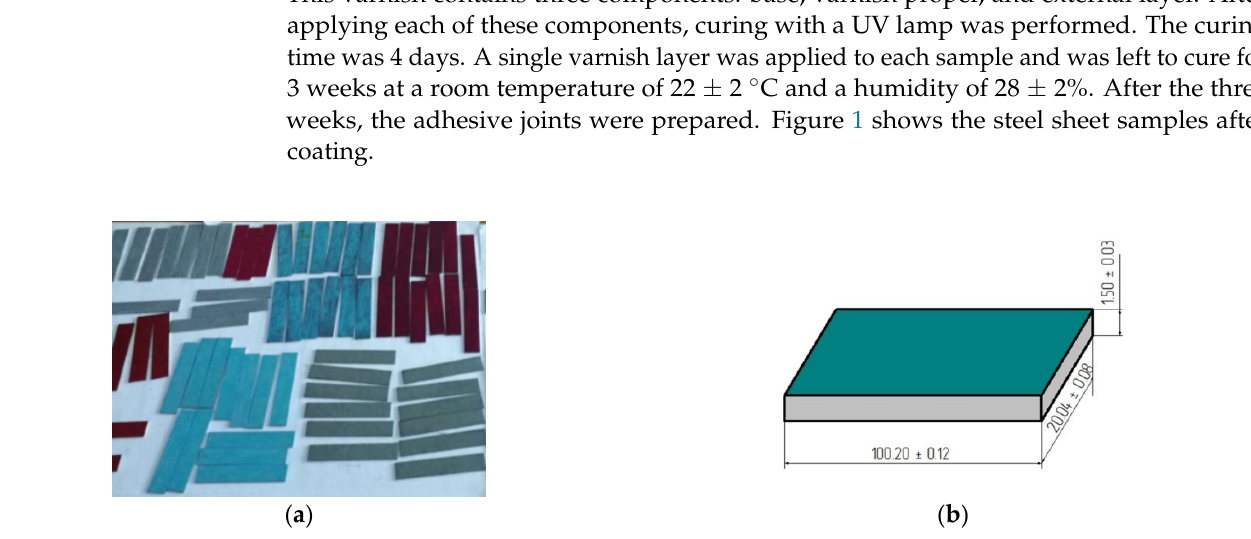
Figure 1. Sample of steel sheets with varnish coats: ( a ) view of samples of steel sheets with coatings; ( b ) scheme and dimensions of a steel sheet sample in mm.